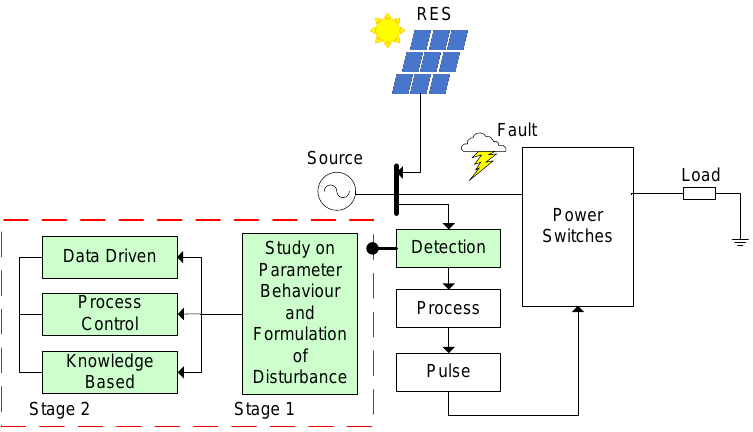
Figure 14. Detection block in a control scheme for PQ compensation device.